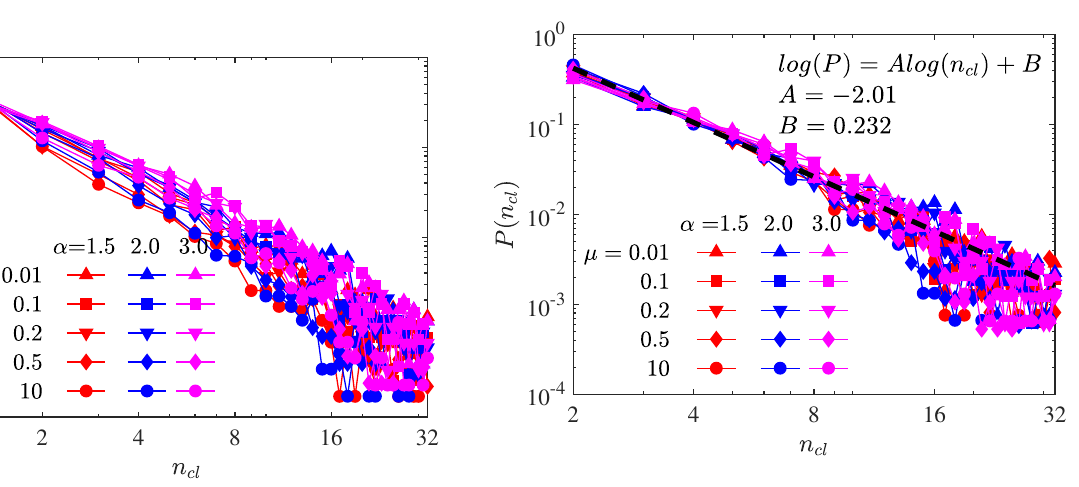
Figure 7. The cluster size PDFs, P ( n cl ), for various aspect ratios α and intergranular friction coe ffi cients µ appear to collapse onto a master